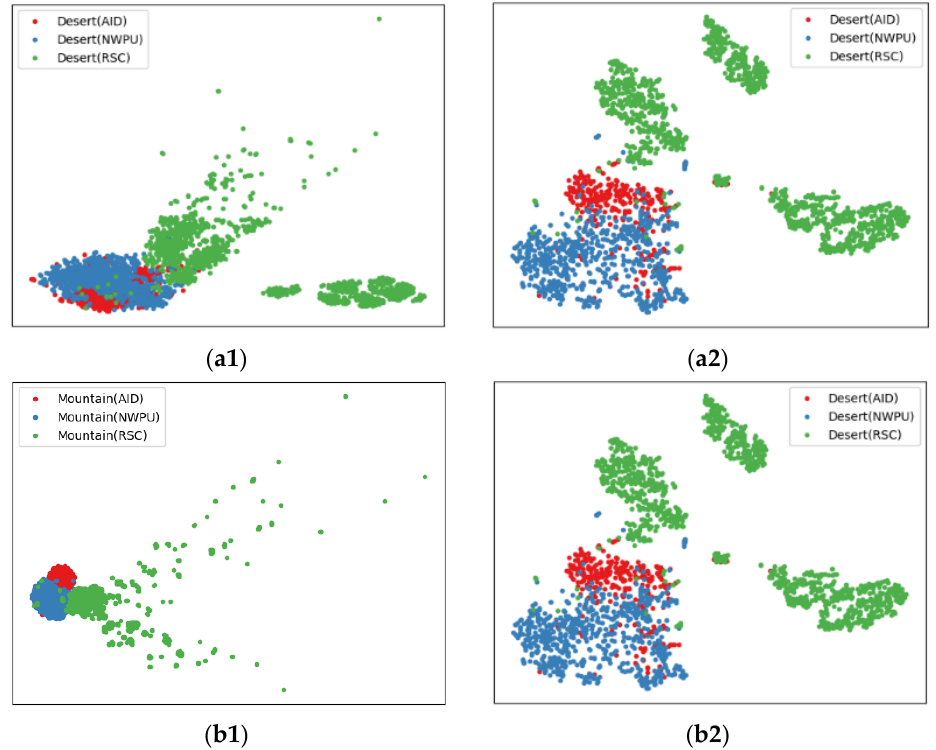
Figure 13. 2-D scatter plots for desert and mountain scenes feature which generated with t-SNE algorithm among the three datasets. ( a1 , a2 ) indicates the visualization result of desert features ( b1 , b2 ) represents the visualization result of mountain features. The first column represents the visualization results of 131,072-dimensional features acquired in the fourth layer of backbone, the second column indicates the visualization results of 128-dimensional features acquired at fourth layer and fully connected layer.